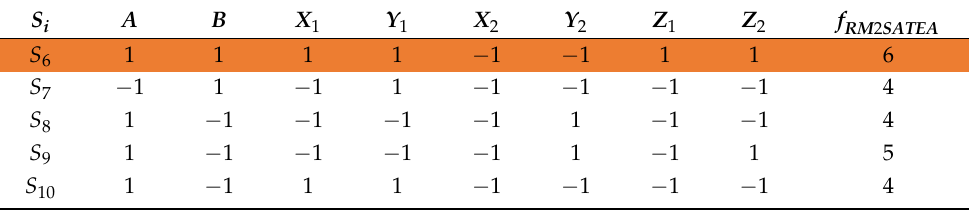
Table A2. S 6 selected as candidate in Party